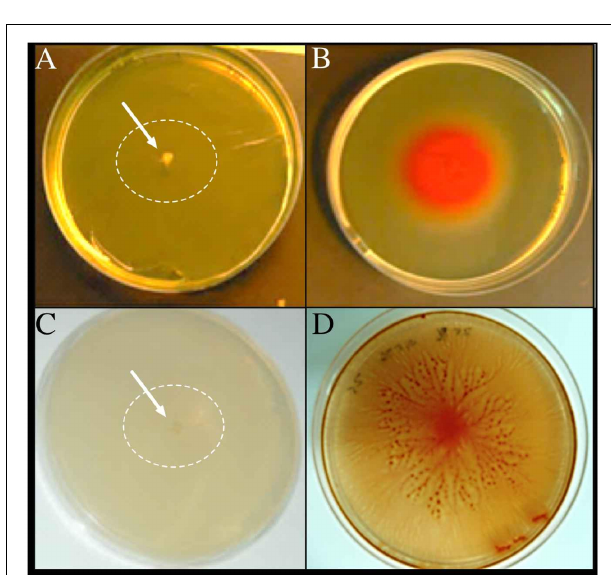
FIGURE 4 | Swimming and swarming motilities of Vibrio sp. The microorganism was adapted to grow with 0 g/L NaCl (A,C) and 25 g/L NaCl (B,D) . Cells were inoculated in their respective salts concentration in the swim (A,B) and swarm (C,D) plates and photographed after 72 h of incubation at 30 ◦ C. The arrows and white circles highlight the single colonies in absence of NaCl.